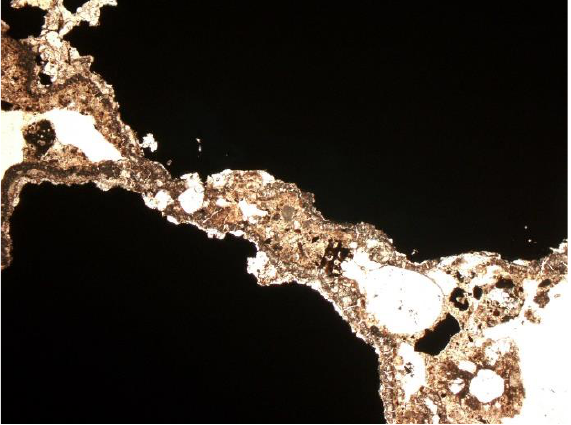
Figure 20. Metallic substance, shiny. SP2 sample, thin section, 1P, 100×, transmitted light.